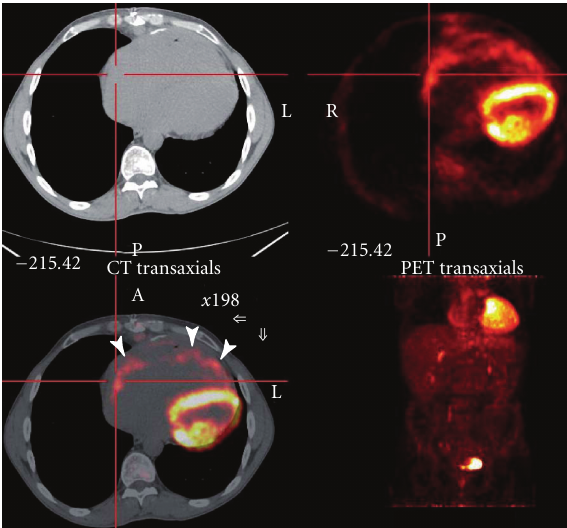
Figure 4: FDG-PET in the transaxial plane shows moderate FDG uptake (arrows) involving mainly the right